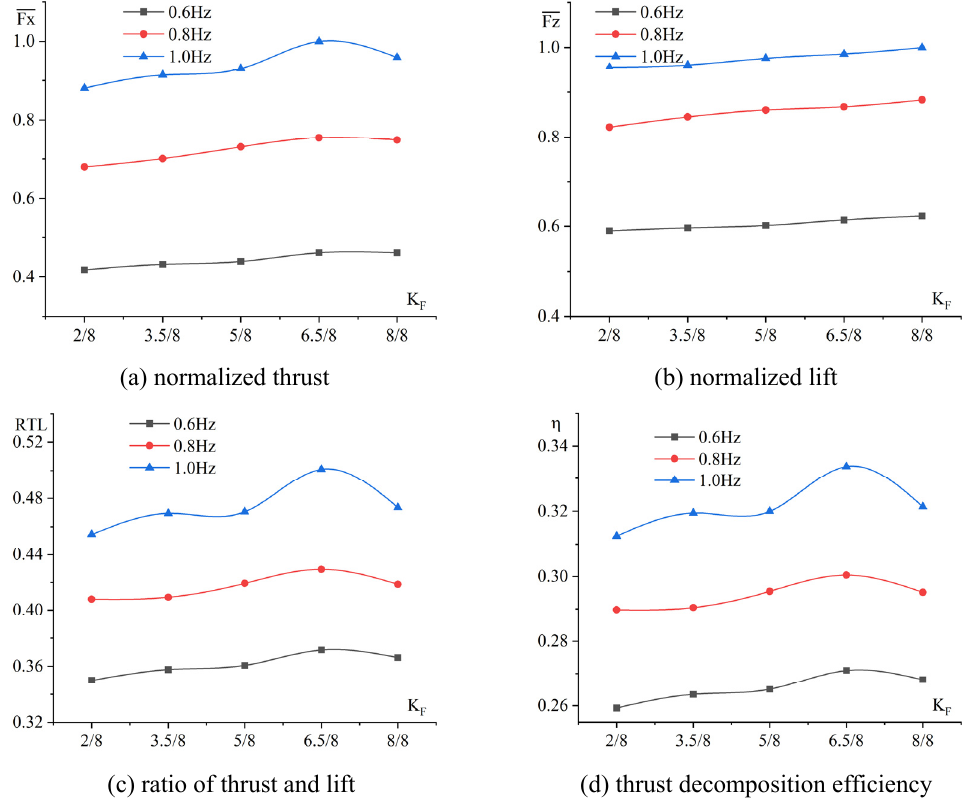
Figure 6. Results of leading edge.